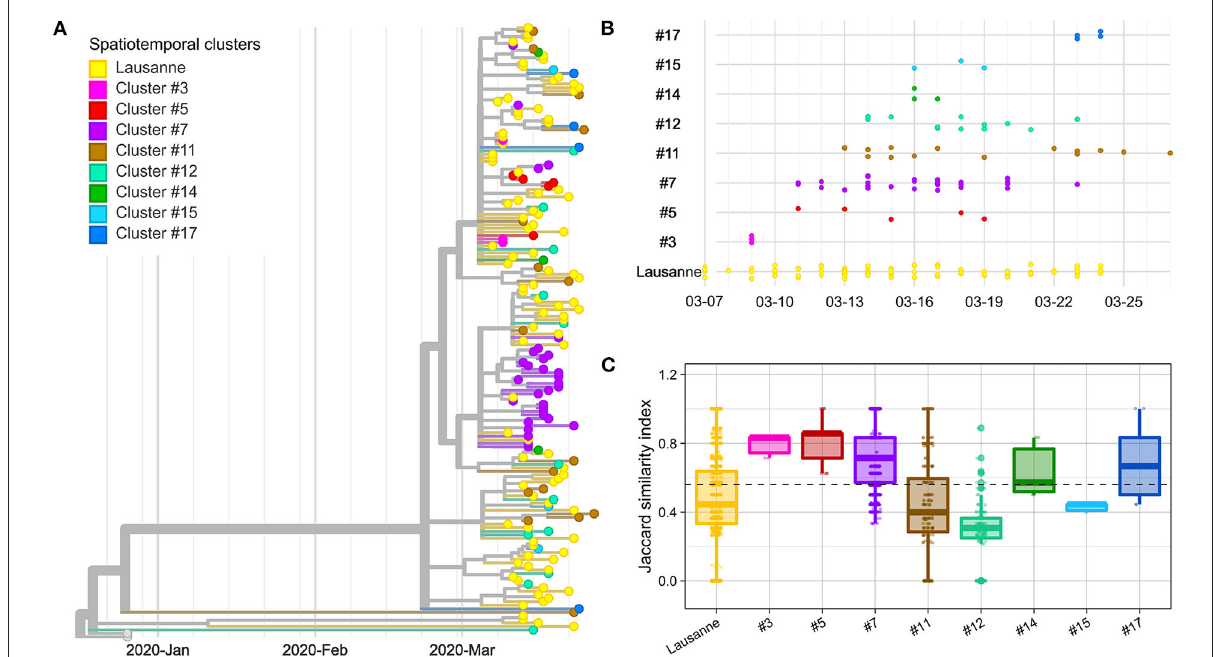
FIGURE2 Genetic distance between and within spatiotemporal clusters. (A) Phylogenetic tree with 172 sequences and 2 Wuhan reference genomes. (B) Timeline of cases appearing in geographical regions. (C) Jaccard similarity within geographical regions. Jaccard distance was calculated between all pairs of samples in the same region. The overall median is indicated as a dotted line. The geographical regions were ordered based on the date of the first case in the